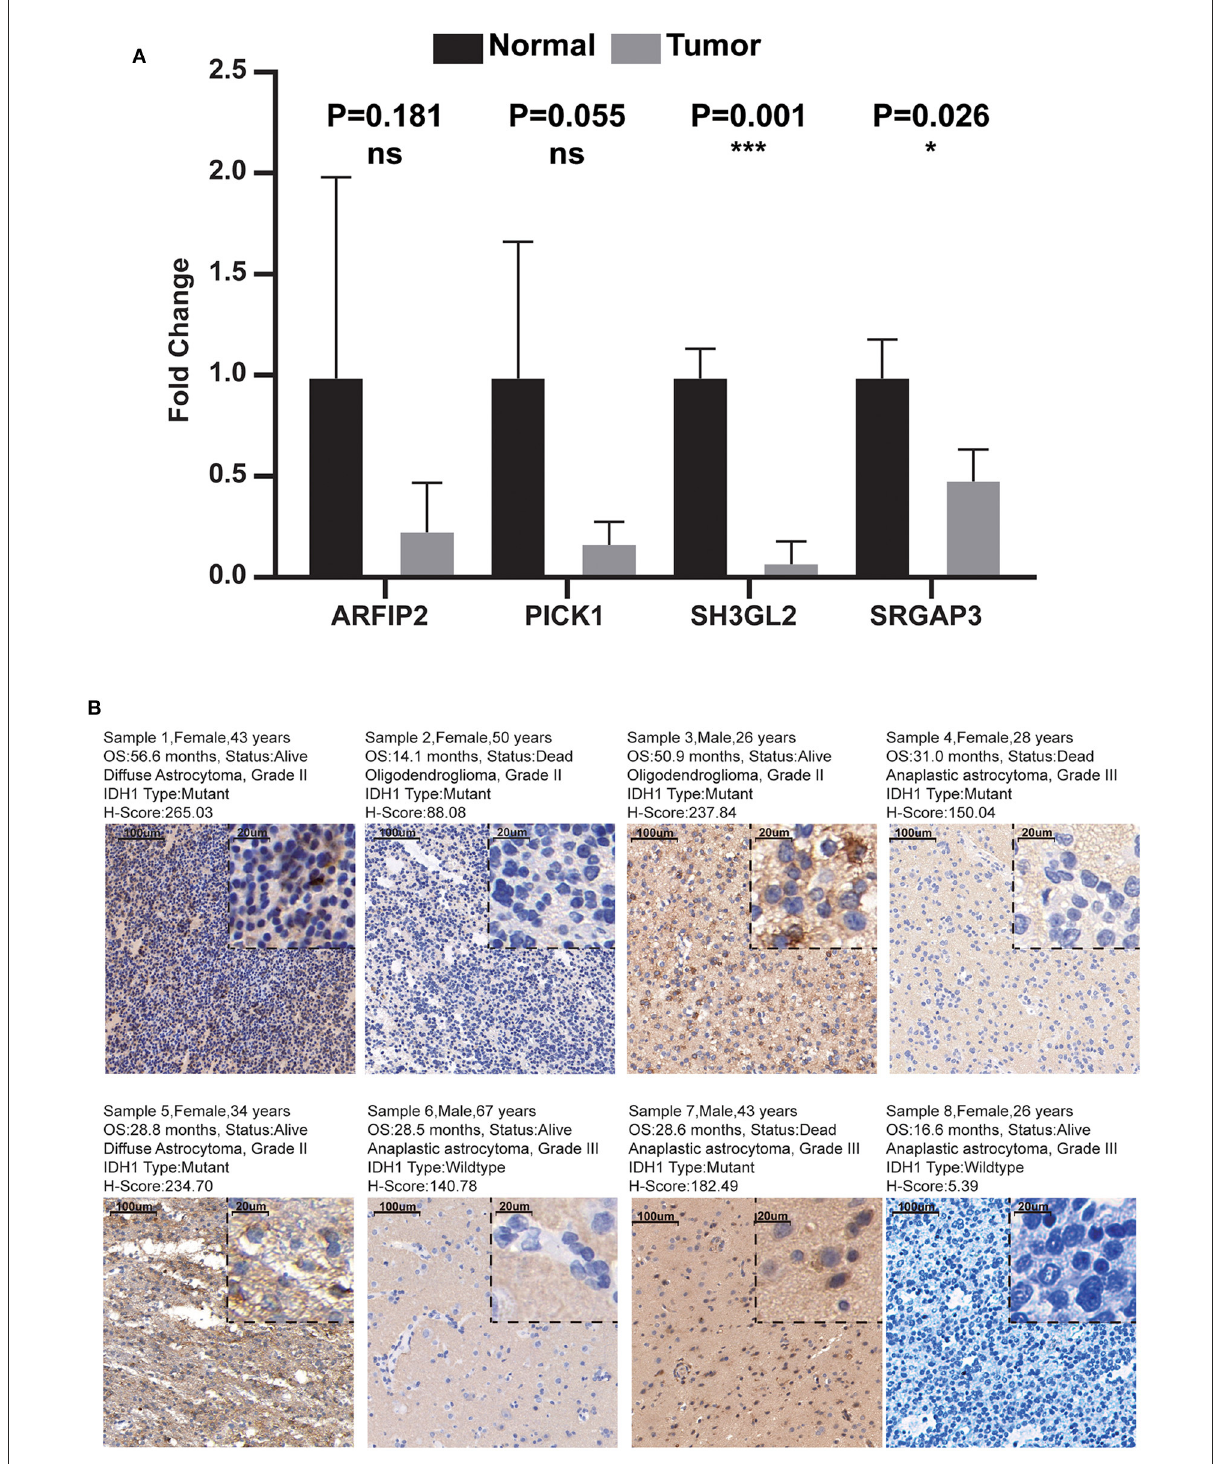
FIGURE10 Results of qRT-PCR and IHC. (A) Expression distribution of risk score MTRGs in normal brain and glioma samples. Asterisks represent level of significance * p ≤ 0.05, ***, p ≤ 0.001, ns, not statistically significant. (B) Immunohistochemical results of eight glioma samples (magnification, 10 × and 40 ×